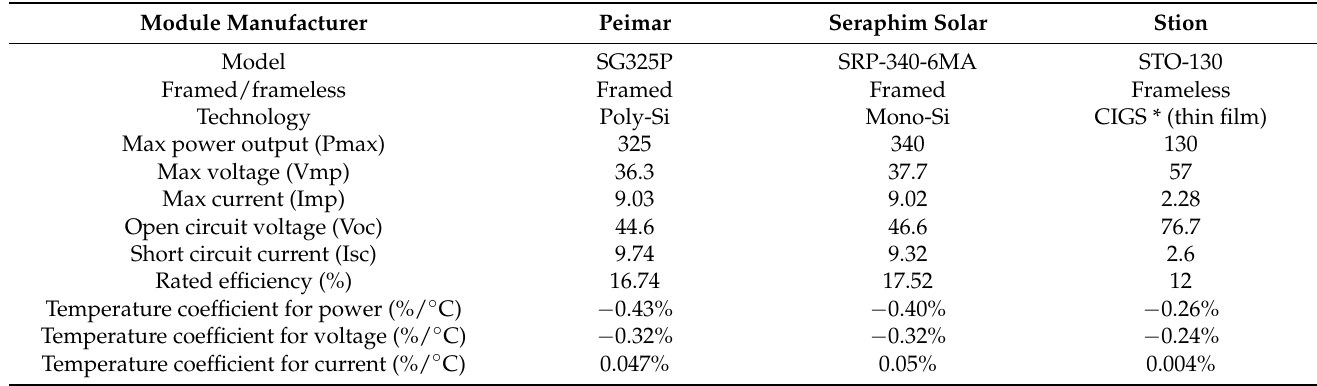
Table 2. Specifications of PV